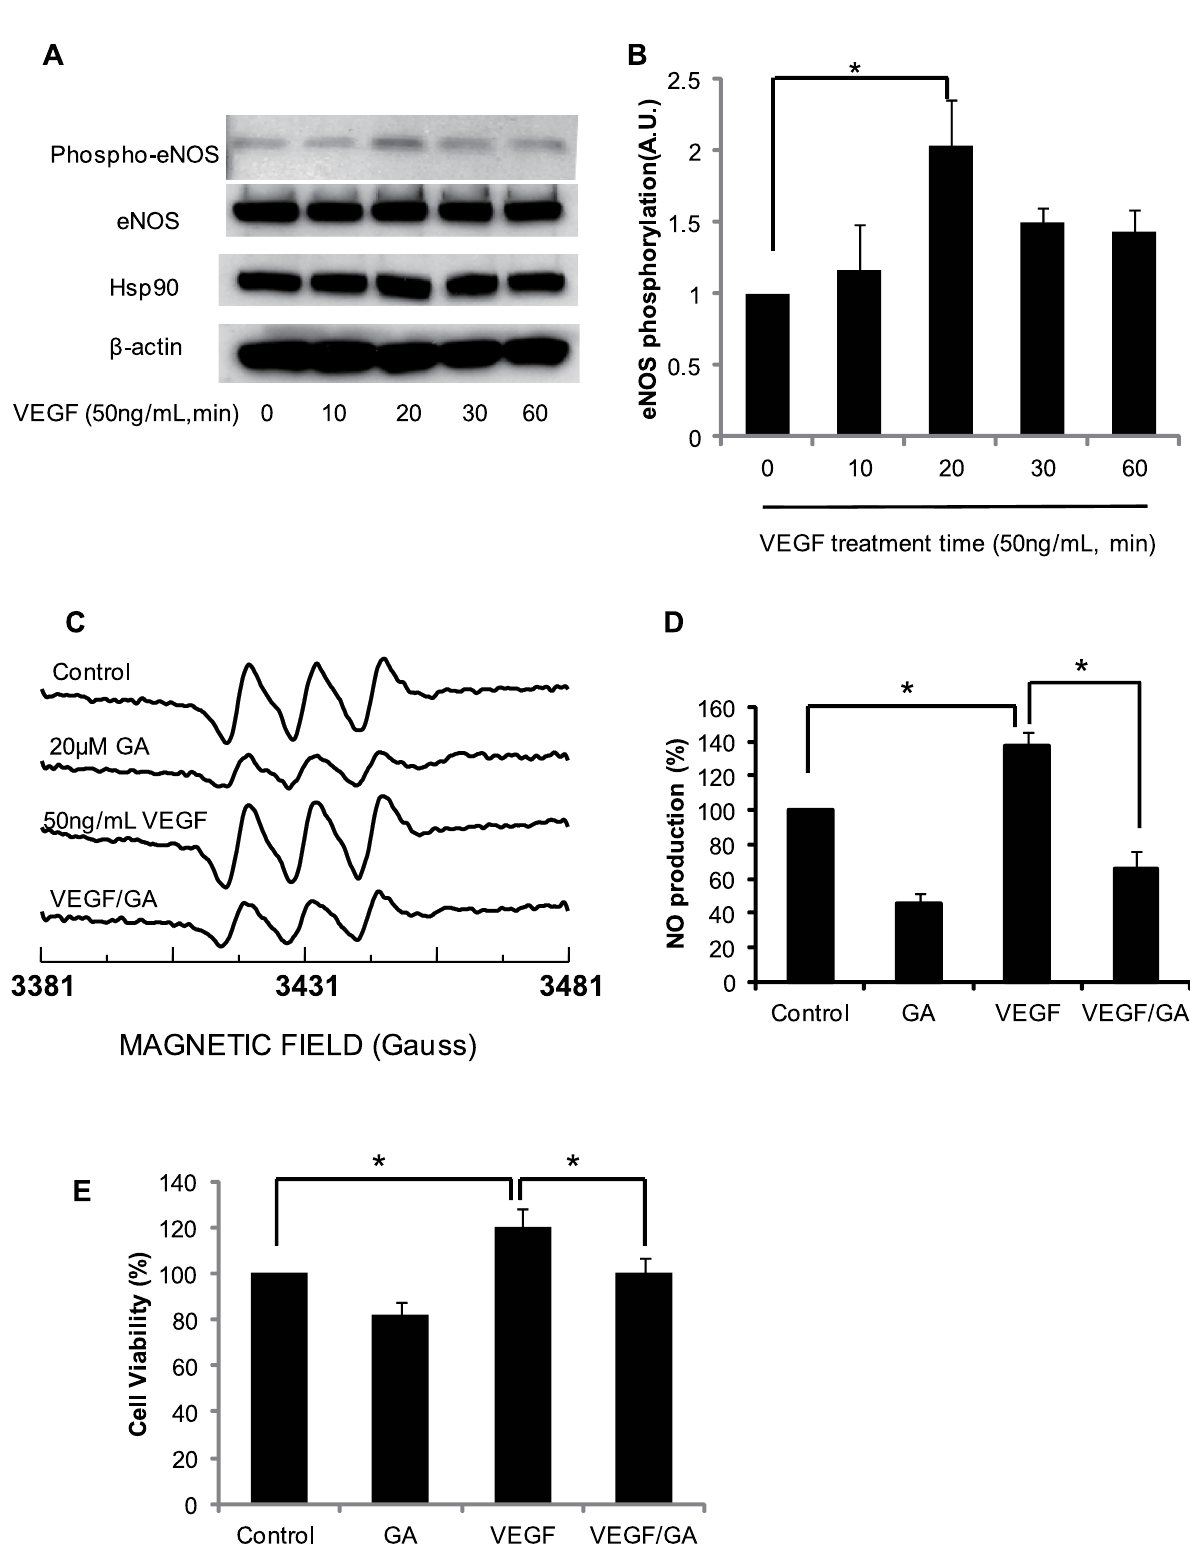
Fig 7. Inhibition of Hsp90 abolished VEGF-mediated eNOS phosphorylation and decreasedNO production and cell viability in BAECs. (A and B) BAECs were treated 50ng/mL VEGF indicatedtime. The cell lysates were harvestedfor western blot using indicated antibodies( * , P > 0.05,comparedto control; n = 3). (C and D) In different experiments, BAECs were treated with 50ng/mLVEGF in the